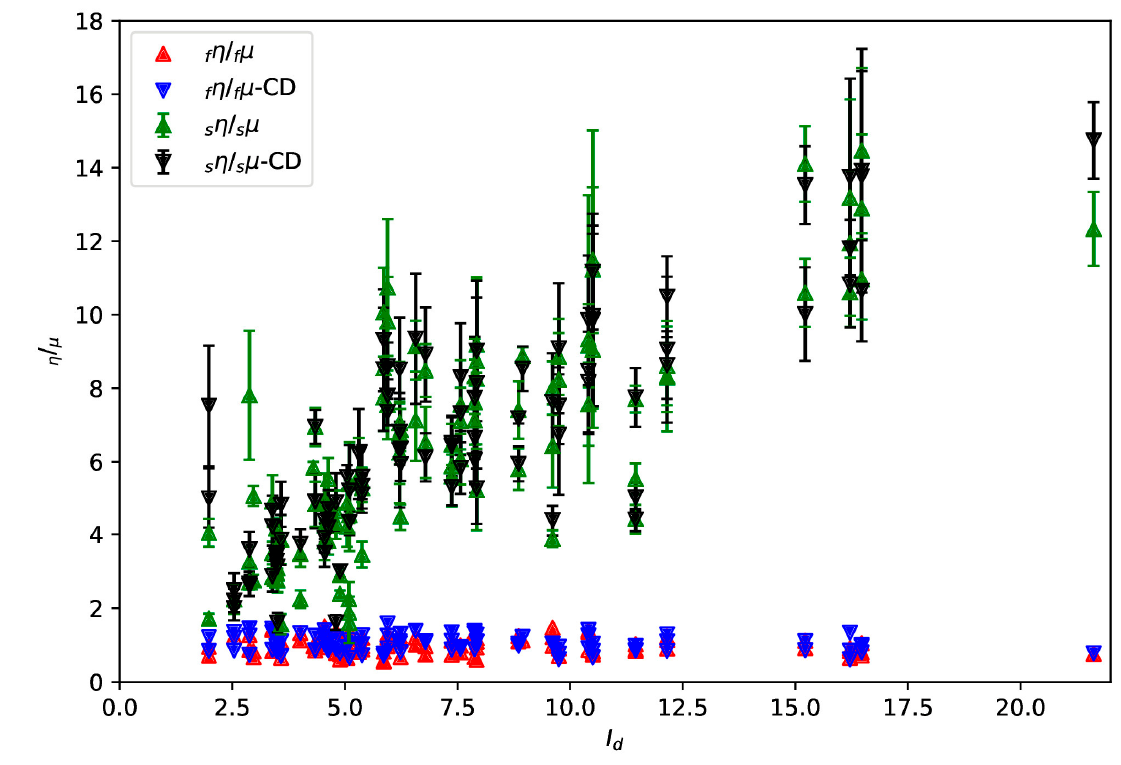
Figure 5. Values of s η / s μ of dampers and f η / f μ of frames under the maximum considered